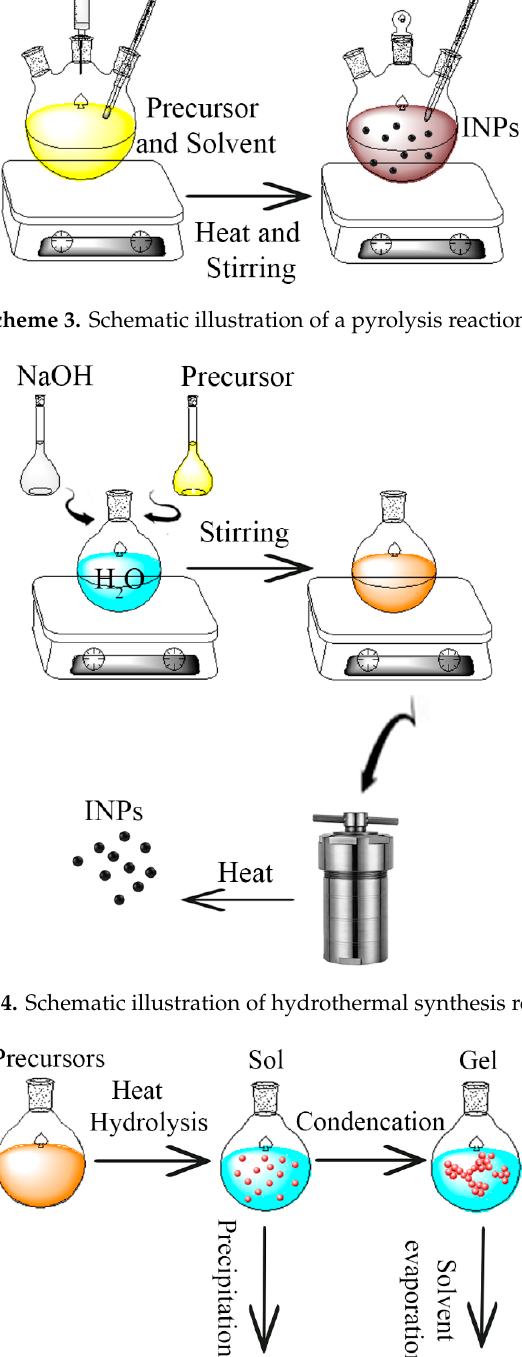
Scheme 2. Schematic illustration of a polyol reaction.